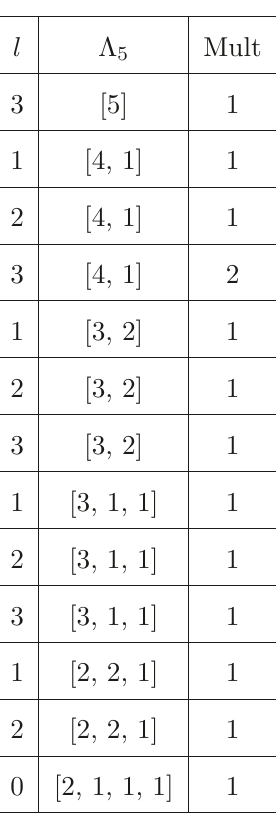
Table 5 . Results for n = 5 fields and k = 3